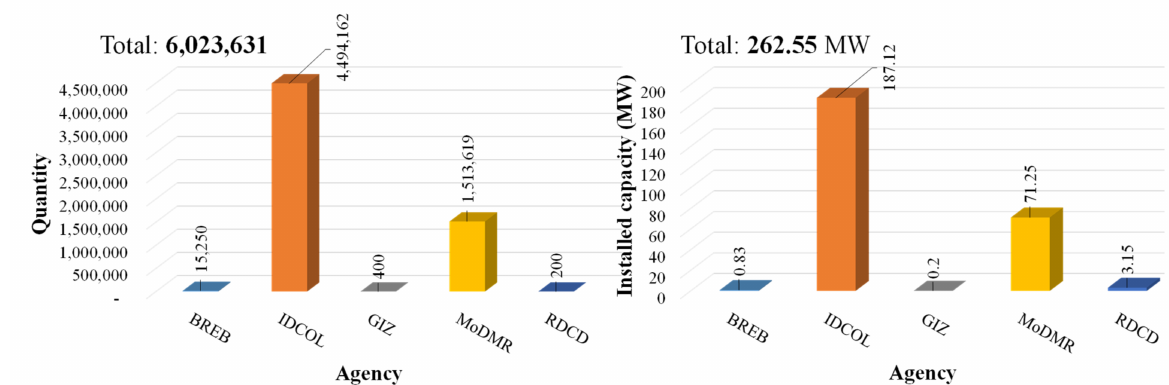
Figure 19. Quantity and installed capacity of solar home systems (SHSs) (authors’ creation based on SREDA data [21]).